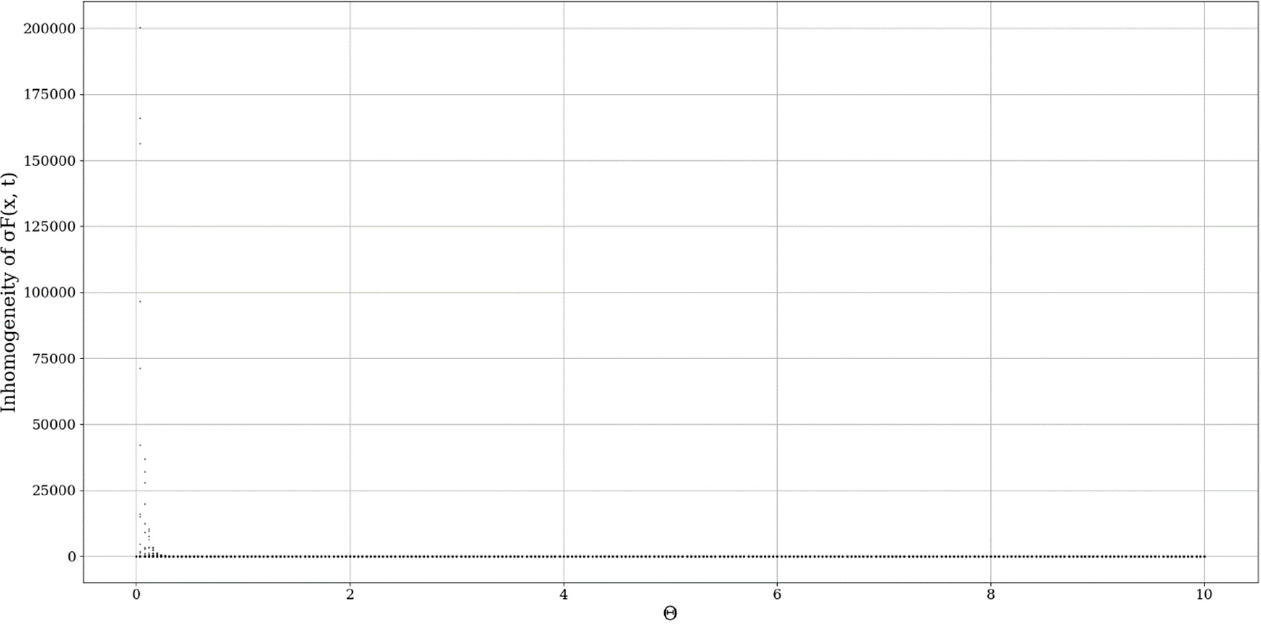
(cid:48) 2 (cid:105) Figure 8. (cid:104)| σ F | example plot with θ as control parameter; ξ = 9; µ = Figure 8. 〈|σ (cid:2890) (cid:3364)(cid:3364)(cid:3364)| (cid:4593)(cid:2870) 〉 example plot with θ as control parameter; ξ = 9 ; μ = 1 .